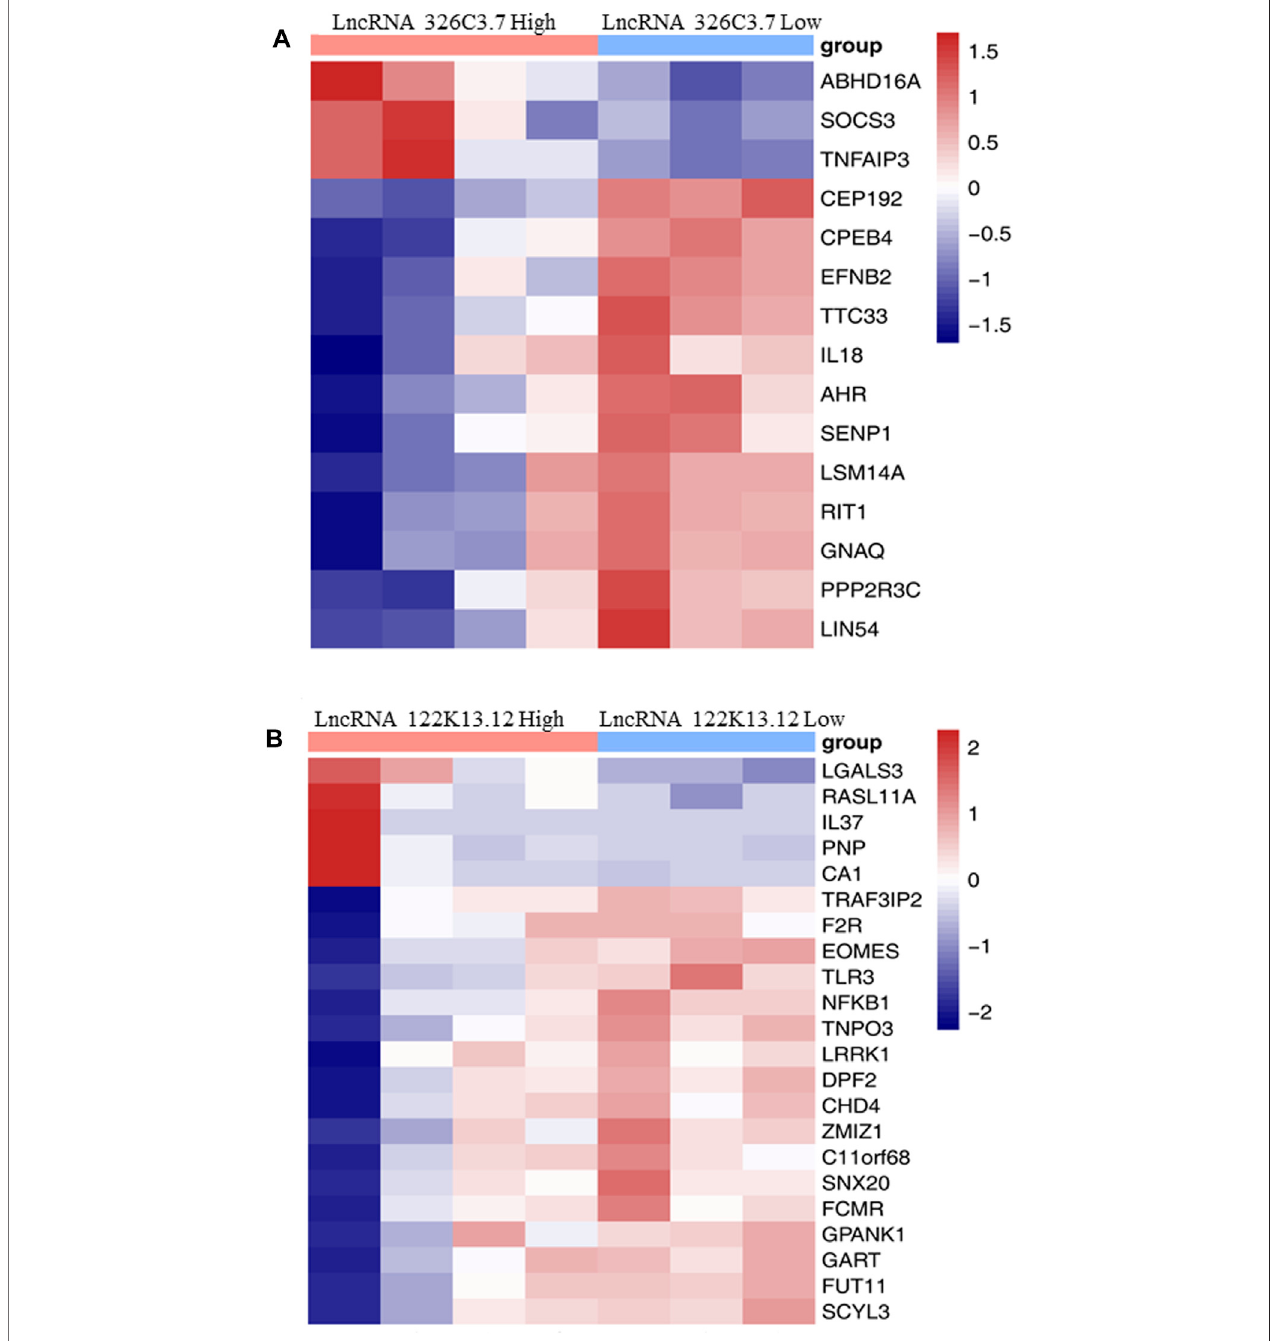
FIGURE 5 | Heatmap showing the association between the expression level of target lncRNAs with AS-related biomarkers. (A) Heatmap showing the association betweentheexpressionleveloflncRNA326C3.7withAS-relatedbiomarkers. (B) HeatmapshowingtheassociationbetweentheexpressionleveloflncRNA122K13.12 with AS-related